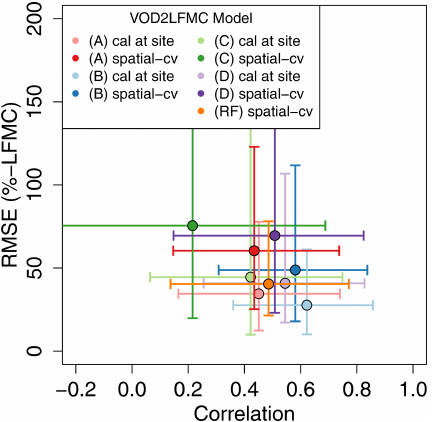
Figure 6. Performance of the models A–D using Ku-VOD after calibrating each model for each species at each site (cal at site) and after using sites as test data in spatial cross-validation after the application of random forest to predict model parameters (spatial- cv). The global RF model (shown in orange) was directly trained against LFMC measurements from multiple sites. Shown is the root mean squared error (RMSE) and correlation coefficient between es- timated and measured LFMC. Dots and bars are the median and range from the 5th–95th percentiles across all sites,